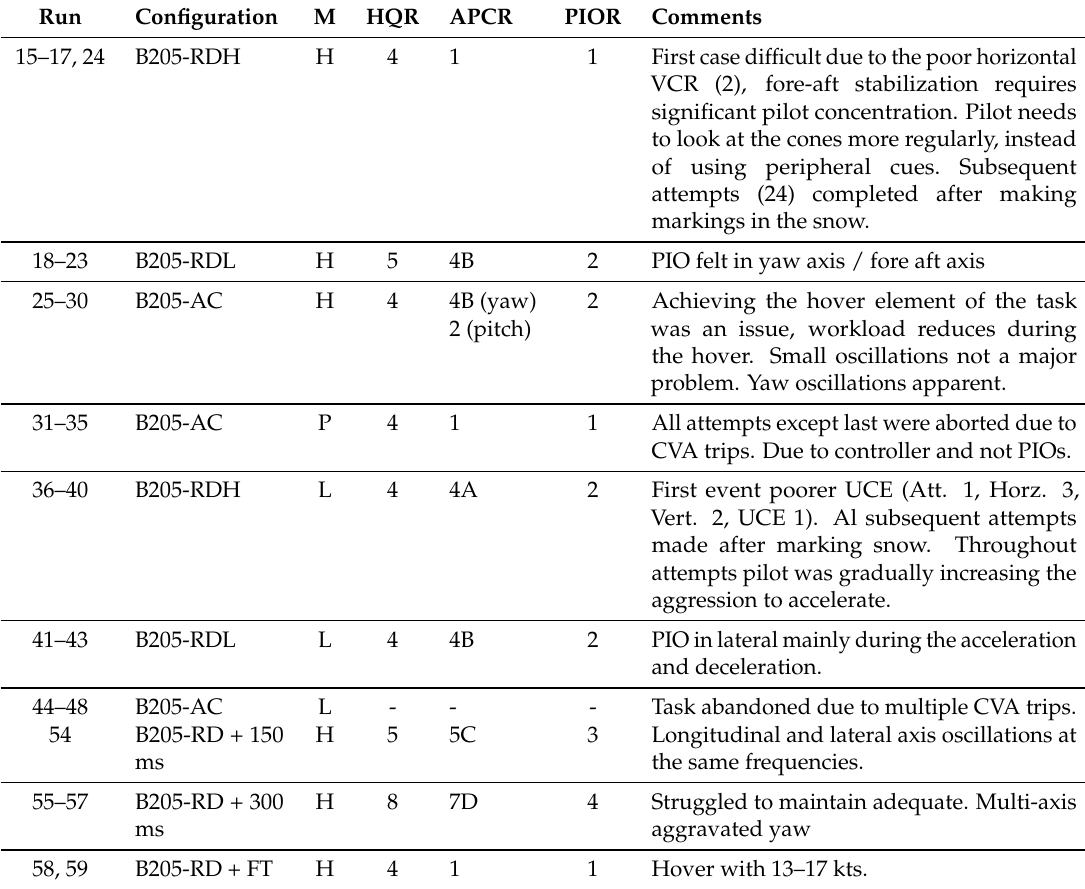
Table A2. Day 2: 5th March 2019, Aircraft Bell 205A,